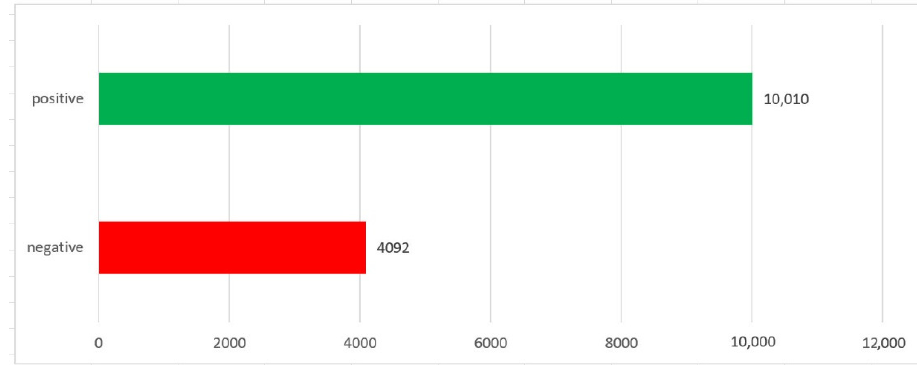
Figure 9. Polarity of comments. Green—positive, red—negative.